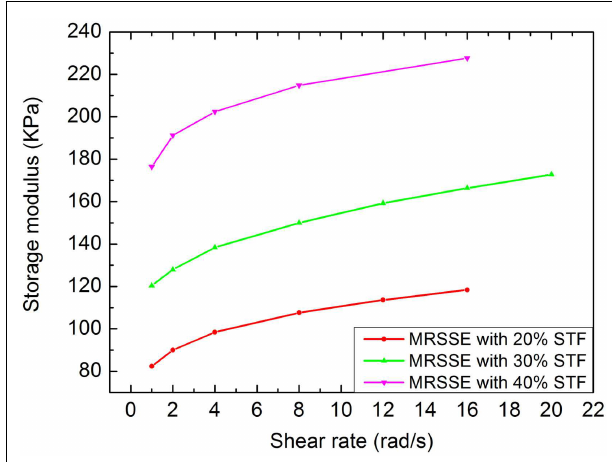
FIGURE 11 | Storage modulus as a function of shear rate for MRSSE with different STF fraction